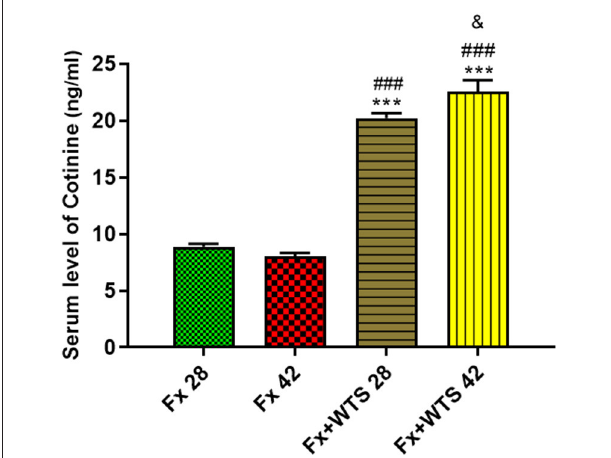
FIGURE 3 | Effects of waterpipe tobacco smoking (WTS) on serum cotinine levels in experimental groups. Fx 28: group subjected to room air for 28 days after surgery and a femoral bone fracture, Fx 42: group subjected to room air for 42 days after surgery and a femoral bone fracture, Fx + WTS 28: group subjected to WTS for 28 days after surgery and a femoral bone fracture, and Fx + WTS 42: group subjected to WTS for 42 days after surgery and a femoral bone fracture. The results are presented as mean ± SEM, n = 10. *** P < 0.001 vs. Fx 28; ### P < 0.001 vs. Fx 42; & P < 0.05 vs. Fx + WTS 28.